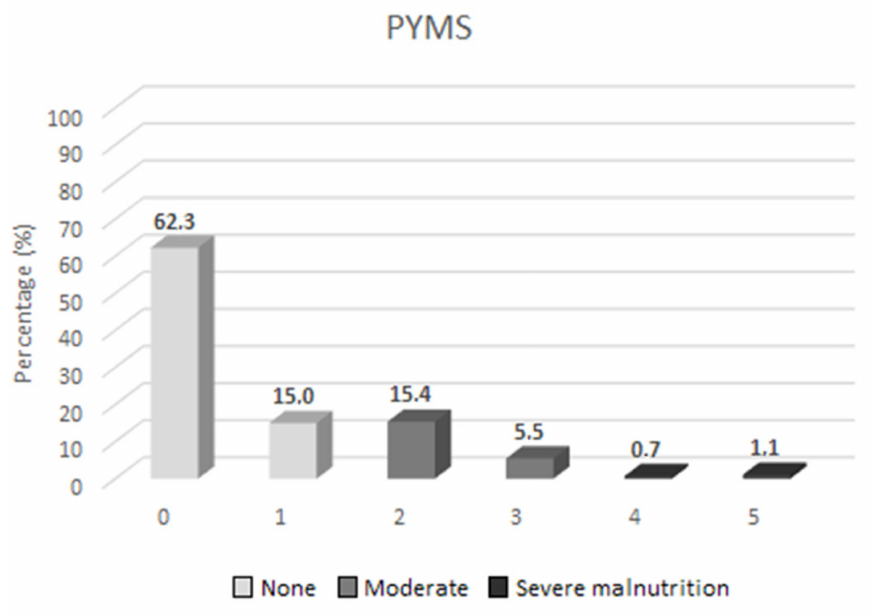
Figure 1. PYMS values; percentage; PYMS 0, 1, 2, 3, 4, and